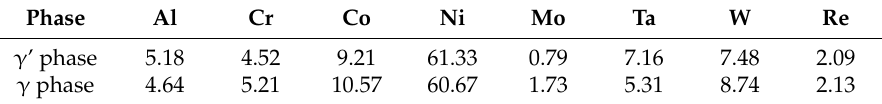
Figure 1. Microstructure of the nickel-based single crystal. Table 1. Chemical constituents of the nickel-based single crystal (mass fraction%).